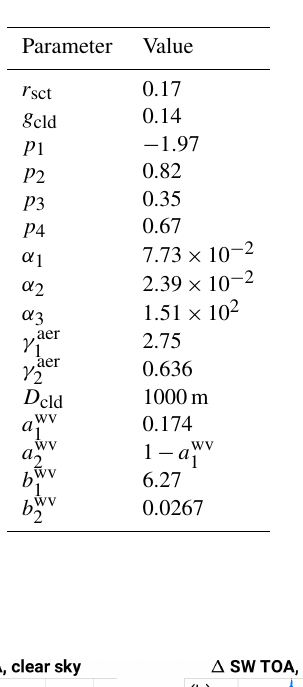
Table A6. Shortwave radiation parameters.